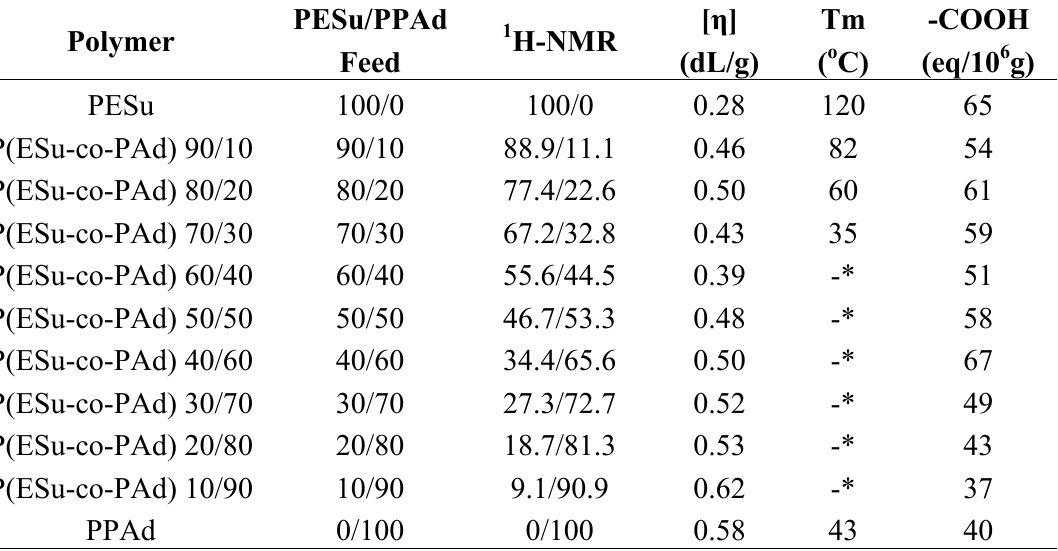
Table 1. Characteristics of prepared P(ESu-co-PAd)